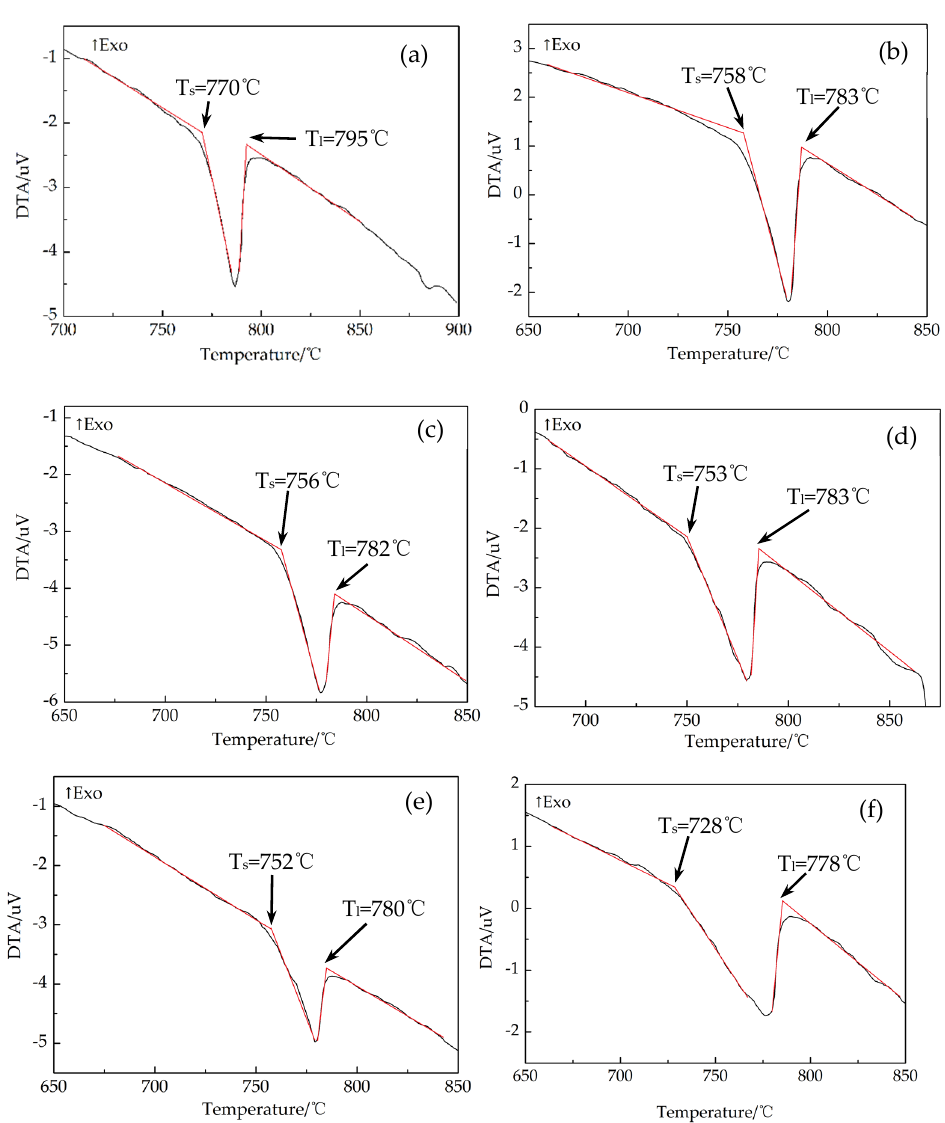
Figure 1. DTA curves of the novel low-silver filler metals: ( a ) 12AgCuZnSn-1In-0.1Pr, ( b ) 12AgCuZnSn-2In-0.1Pr, ( c ) 12AgCuZnSn-2In-0.15Pr, ( d ) 12AgCuZnSn-2In-0.3Pr, ( e ) 12AgCuZnSn-2In-0.5Pr, ( f ) 12AgCuZnSn-5In-0.5Pr.